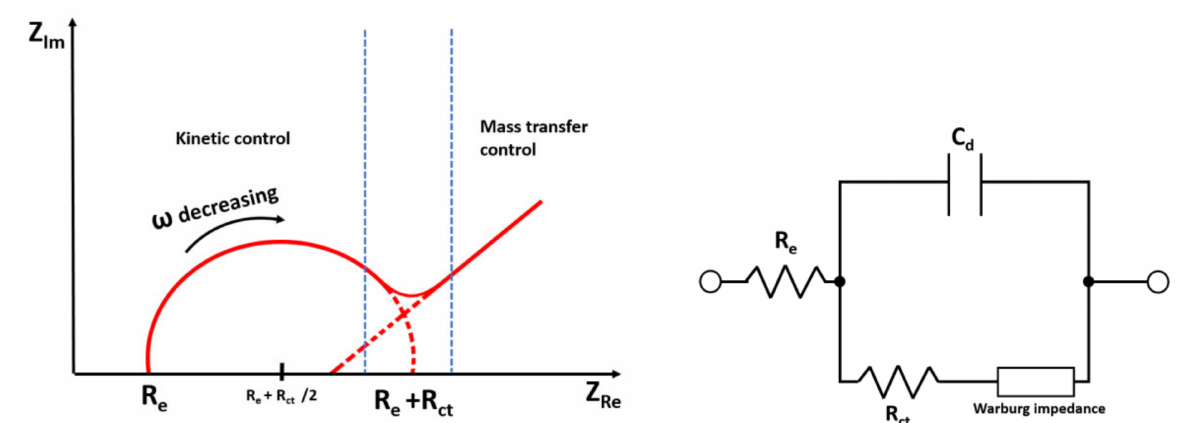
Figure 12. Depiction of the typical impedance spectrum (red line, dependance of the real Z Re and imaginary Z Im parts of impedance) and equivalent circuit. C d is an interface electrode-fluid capacitance, R e –solution resistance, R ct –charge transfer or polarization resistance, ω –perturbation frequency; Warburg impedance models the diffusion behavior of impedance.